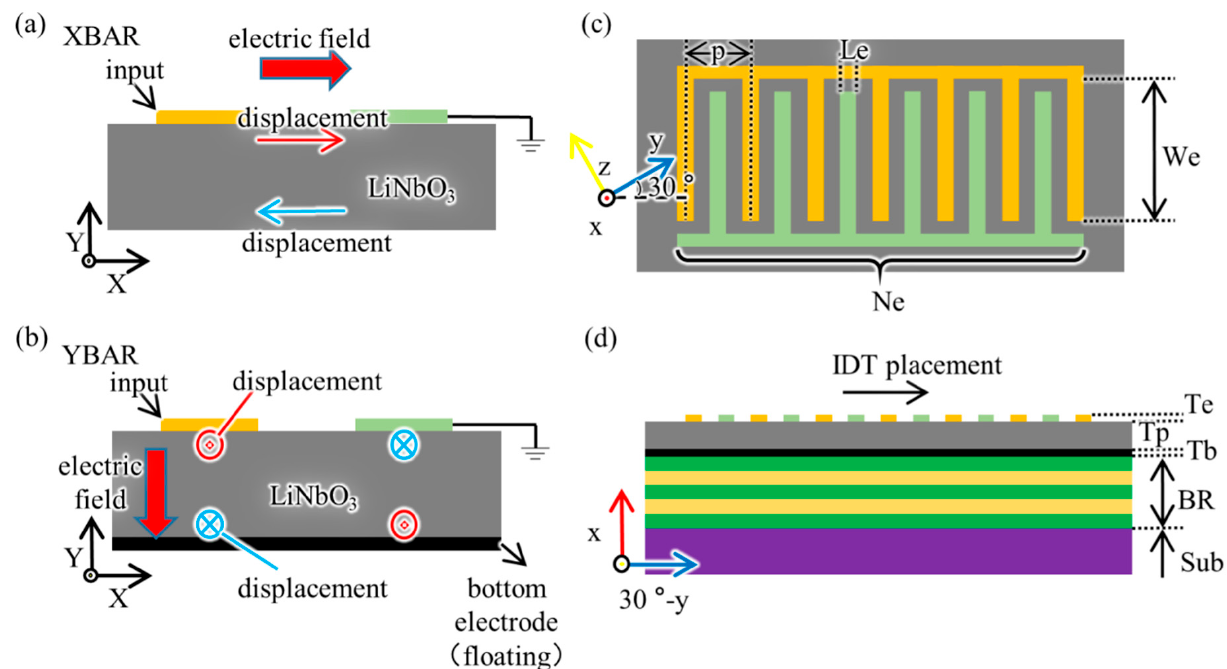
Figure 1. ( Left ) device principal and acoustic displacement of an XBAR and a YBAR. ( a ) an XBAR, electric field applied by the interdigital transducers (IDTs) in the transverse direction (i.e., X direction) was utilized to excite the transverse acoustic shear wave. ( b ) a YBAR, electric field applied by the IDTs in the longitudinal direction (i.e., Y direction) was utilized to excite the longitudinal acoustic shear wave. The red/blue arrows represent the displacement of the excited shear waves. ( Right ) Device configuration of the SM-YBAR in ( c ) top view and ( d ) section view, colored coordinates show the LiNbO 3 orientation in the resonator.